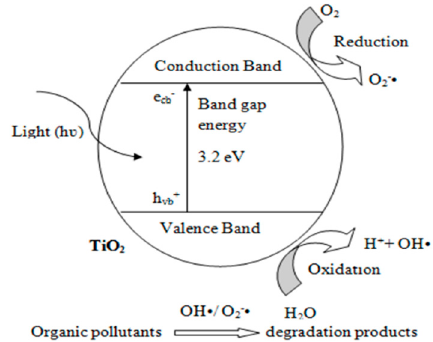
Figure 1. Photocatalytic mechanism for TiO 2 photocatalyst.